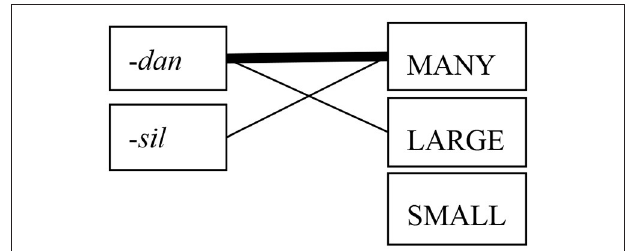
FIGURE 1 | A network with bidirectional connections modeling a production-comprehension dissociation after exposure to nouns suffixed with -dan and -sil paired with multiple large creatures, with -dan being more frequent than -sil (after Kapatsinski and Harmon,